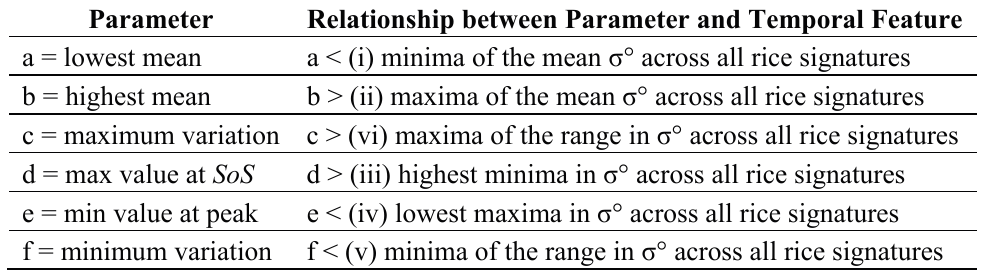
Table 3. Site-specific parameters for the rule-based classification and the criteria used to select them based on temporal